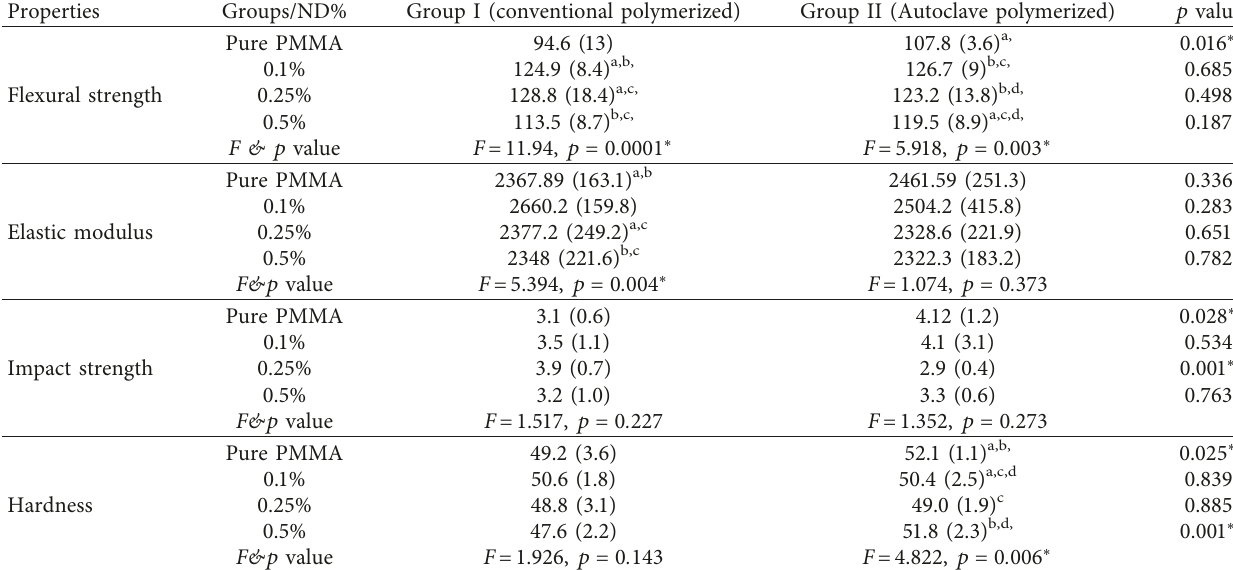
Figure 4: FTIR of (a) conventionally polymerized (0, 0.1, 0.25, and 0.5% ND) and autoclave specimens (0, 0.1, 0.25, and 0.5% ND) in the spectral range of 4000–500cm − 1 . Table 1: Means, standard deviation, and significance of tested